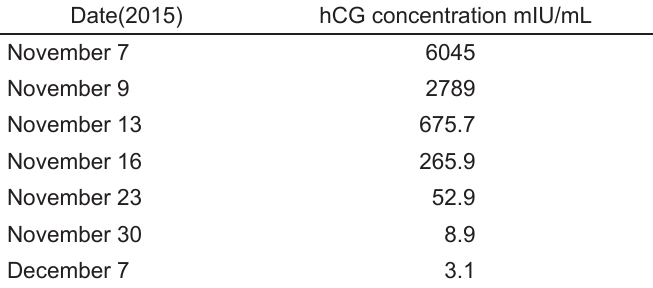
Table 2. Human chorionic gonadotropin concentration (hCG) of the patient from November 7 to December